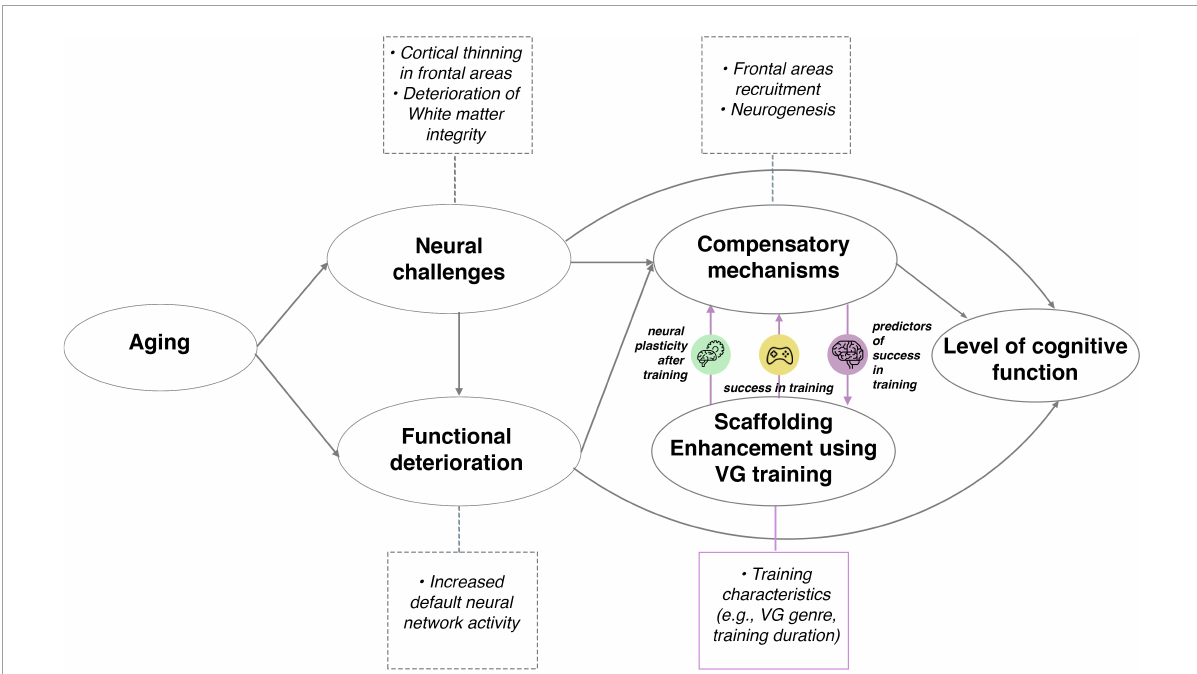
FIGURE4 Relationship between aging, brain structural predictors of VG skill acquisition and neural plasticity after training in the context of the Scaffolding Theory of Aging and Cognition (adapted from Park and Reuter-Lorenz, 2009). The model is extended by the addition of predictors of success in scaffolding enhancement activities (VG training) (marked by purple circle “predictors of success in training,” green circle “neural plasticity after training” and yellow circle “success in training”). Neural and functional challenges appear with aging, which are compensated for by various biological mechanisms. Scaffolding enhancement activities, such as complex, challenging VG training, can improve the compensatory mechanisms, which influence general cognitive functioning as they change with age. Success in VG used as an enhancement activity can be predicted from mainly cortical areas in older and subcortical areas in younger adults. Among the older subjects, those whose compensatory mechanisms in the frontal cortical areas are more effective, perform better in VG training. Instead of the subcortical areas usually linked to the success of VG training in younger adults, the elderly engage cortical structures to the greater extent to successfully perform the task. The “success in training” circle indicates the relationship between the behavioral outcomes of training and compensatory mechanisms as well as later cognitive functioning of people, while “neural plasticity after training” circle indicates the relationship between the training and neural plasticity, which are also linked to compensatory mechanisms and later level of cognitive functioning. Training features (e.g., genre, training duration and frequency) can also interact with the relationship between brain predictors, performance in training and neural plasticity (the purple square). Icons were obtained from